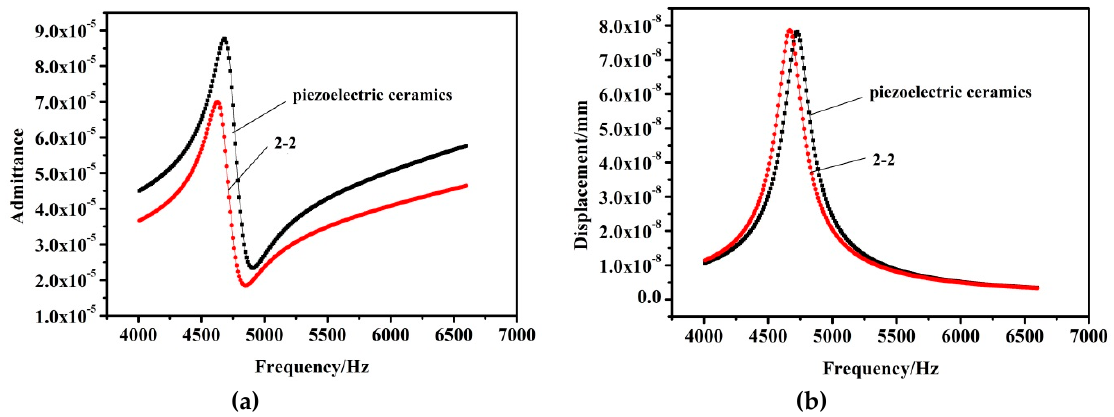
Figure 10. ( a ) Admittance curves of the 2-2 piezoelectric composite bilaminated vibrator and the ceramic vibrator. ( b ) Vibration displacement curves of the 2-2 piezoelectric composite bilaminated vibrator and the ceramic vibrator.